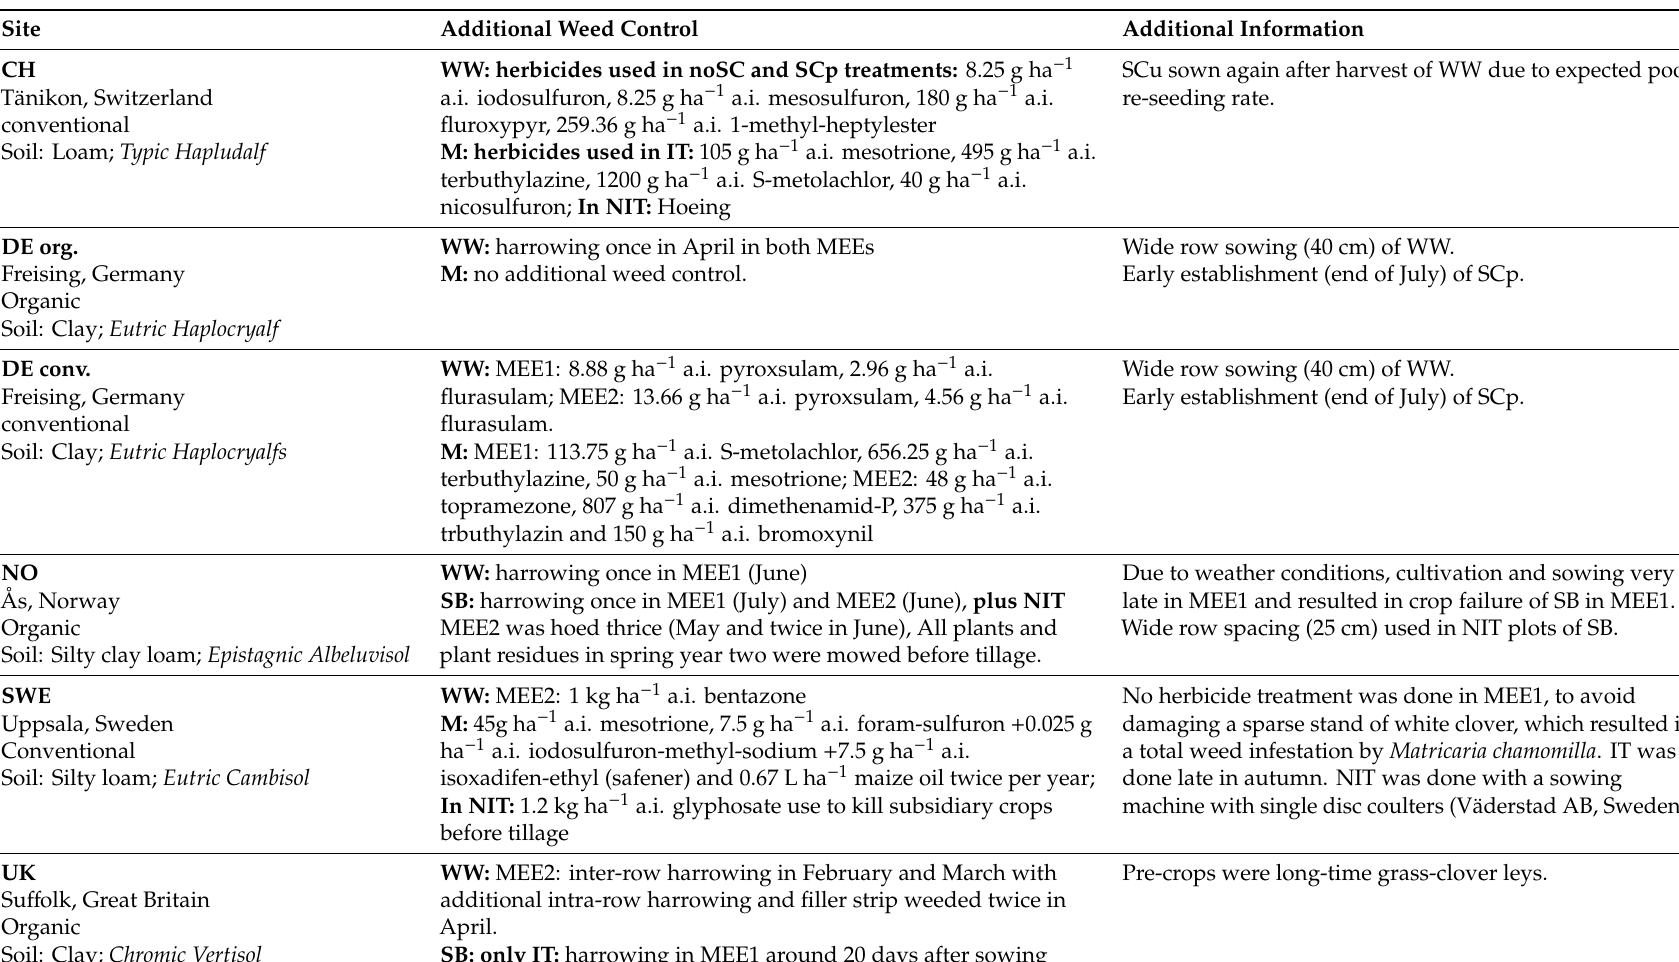
Table 1. Summarized site description. (1st crop: WW—winter wheat, 2nd crop: SB—spring barley or M—maize, SCu—subsidiary crops under-sown, SCp—post-harvest sown subsidiary crops, noSC—control treatment without subsidiary crops, NIT—non-inversion tillage, IT—inversion tillage). Additional Weed